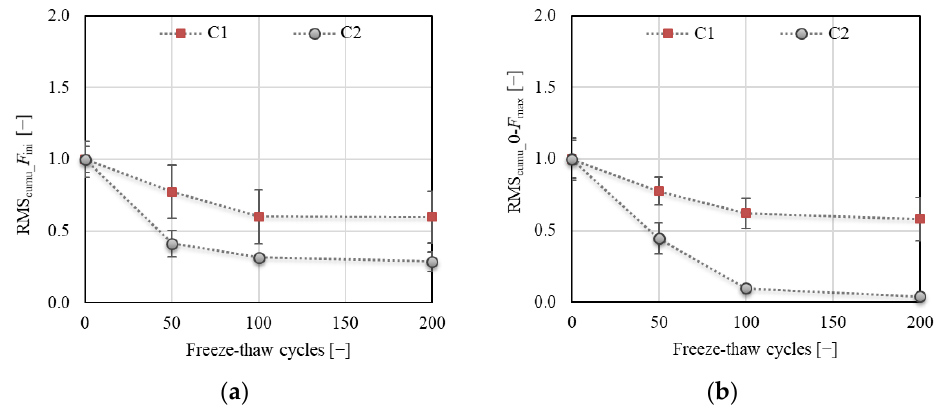
Figure 19. Acoustic emission: ( a ) RMS cumu for F ini ; ( b ) RMS cumu for interval 0– F max